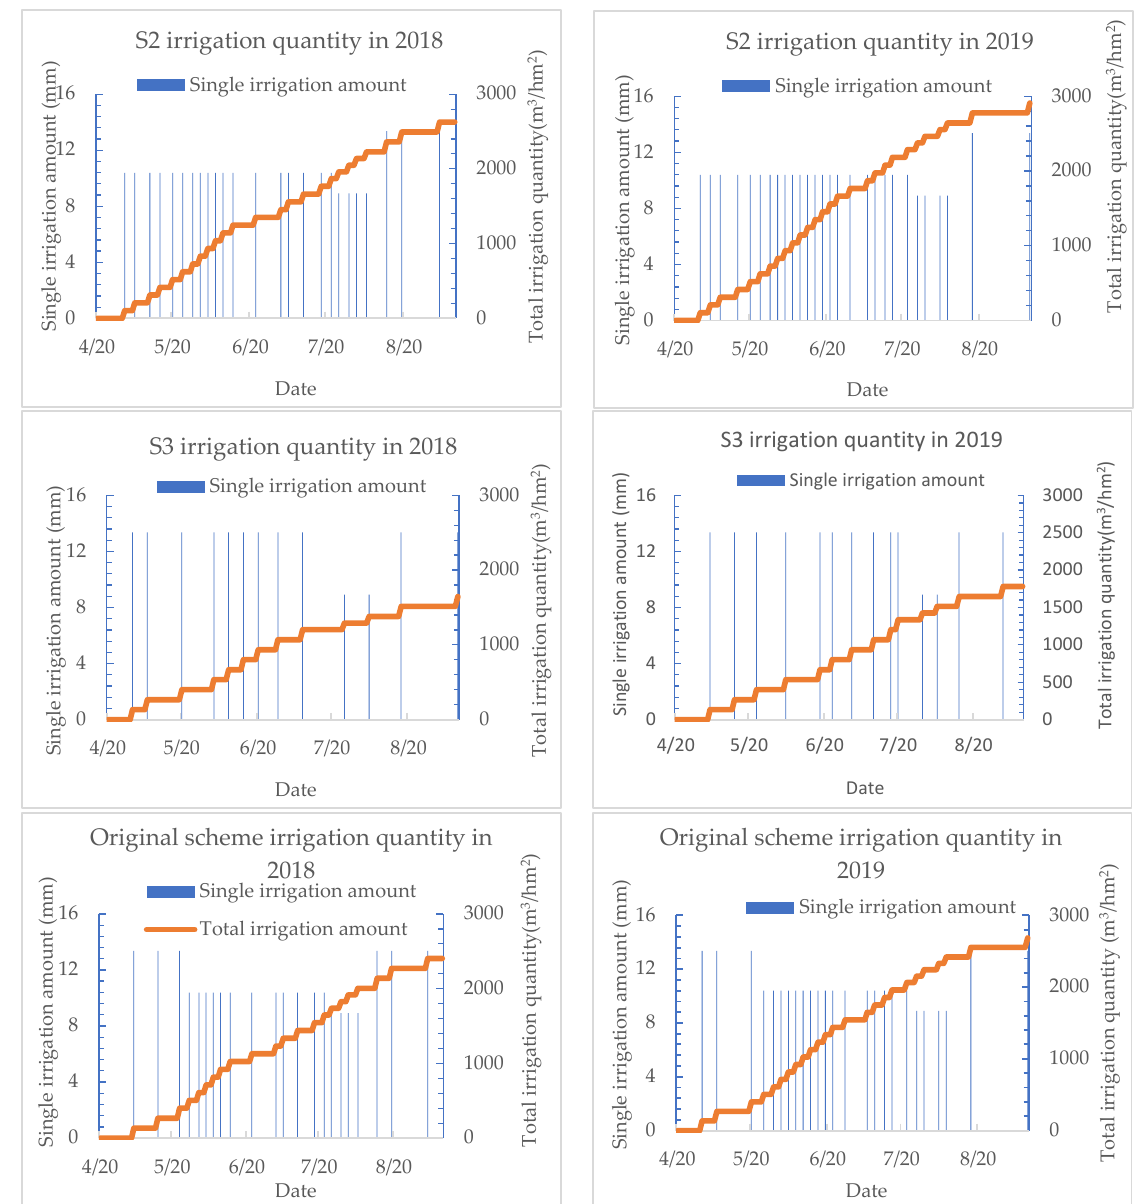
Figure 9. Irrigation distribution of different LIL solutions.